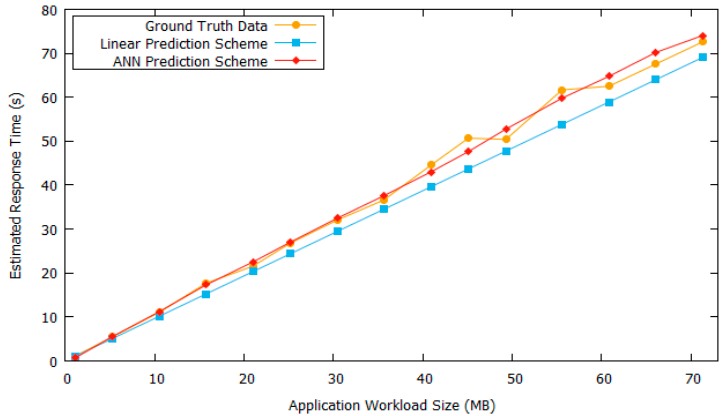
Figure 7. Response time estimation result comparison.